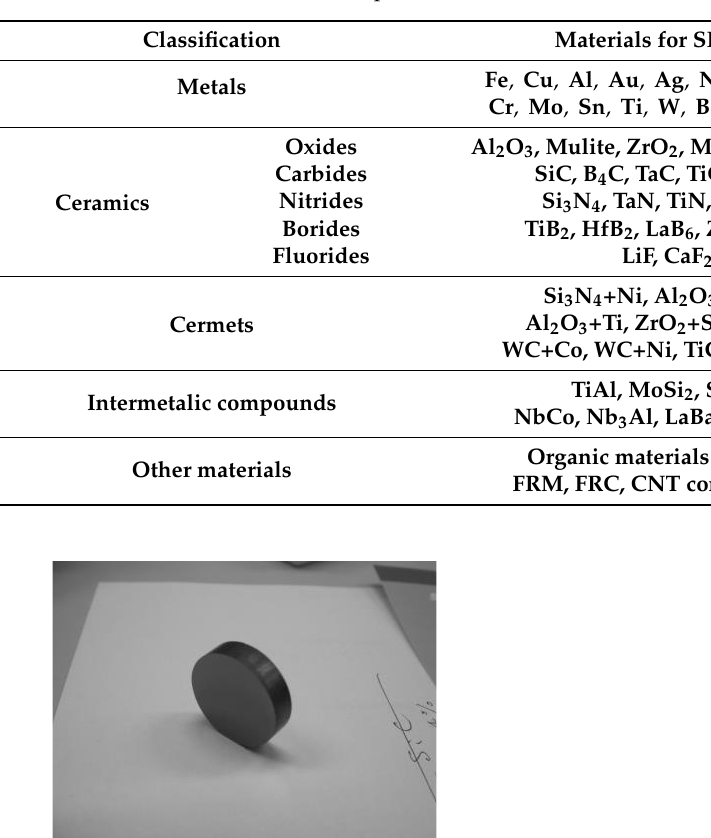
Table 1. Suitable materials for the SPS process.